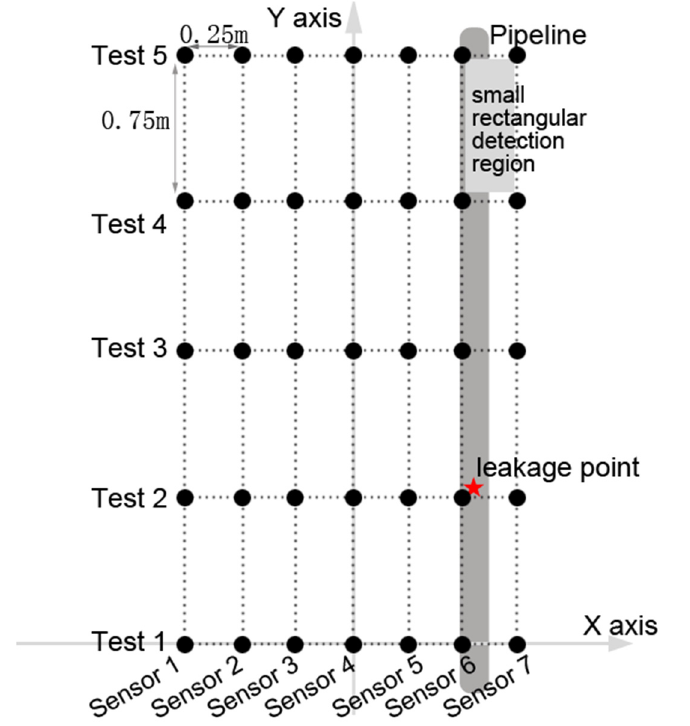
Figure 10. Grid of measurement